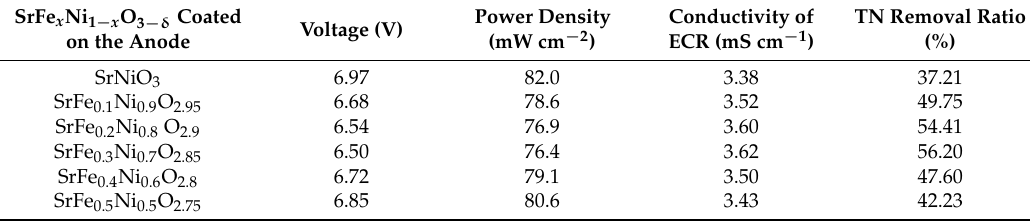
Table 2. The effect of different anodes in ECR for cleaning nitrogenous